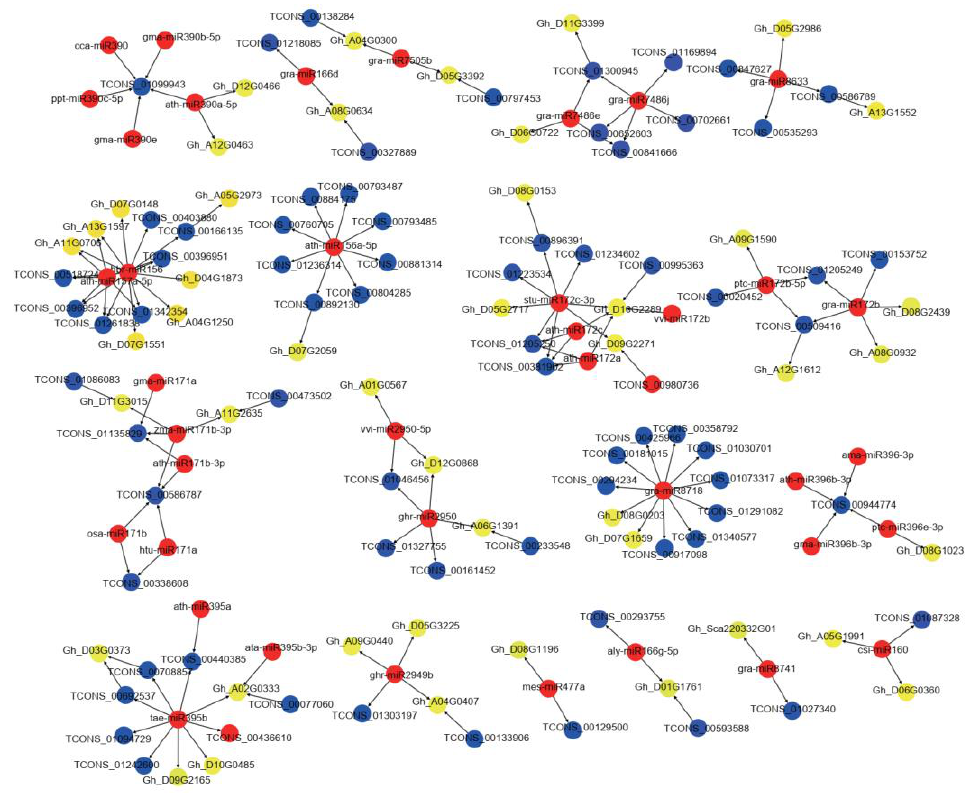
Figure 6. The representative miRNAs-lncRNAs-mRNAs regulatory networks in anther development of cotton. Red nodes: miRNAs; Blue nodes: lncRNAs; Yellow nodes: mRNAs. Arrow direction means regulator to targets.